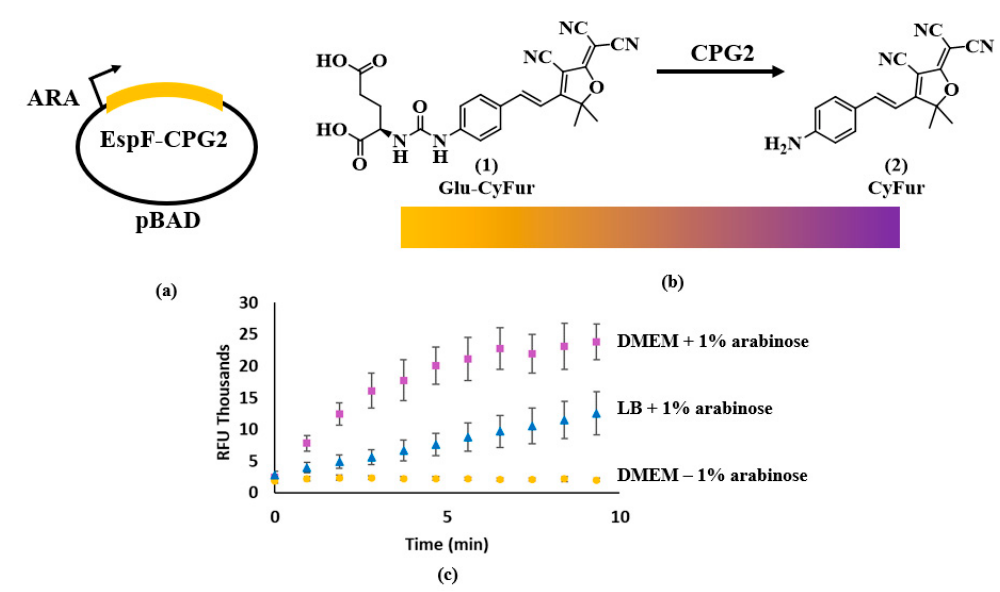
Figure 2. Design of the carboxypeptidase G2 (CPG2)-reporter assay. ( a ) The cpg2 gene was tagged on the amino-terminus with the secretion signal from the T3SS effector, EspF, and expressed under an arabinose-induced promoter. ( b ) CPG2 cleaves its substrate Glu-CyFur ( 1 ) which releases a fluorescent compound, CyFur ( 2 ). ( c ) Over time, fluorescence increases as CPG2 cleave the Glu-CyFur substrate. If the T3SS is not upregulated with DMEM, the fluorescent signal is inhibited as CPG2 secretion decreases. If CPG2 is not produced (such as in the absence of arabinose), no fluorescence is produced since the Glu-CyFur substrate is not being cleaved.